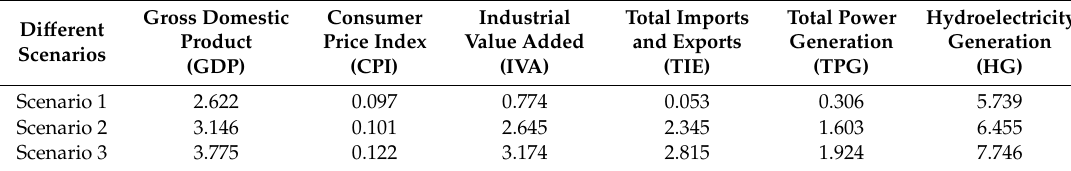
Table 5. Growth rates in di ff erent